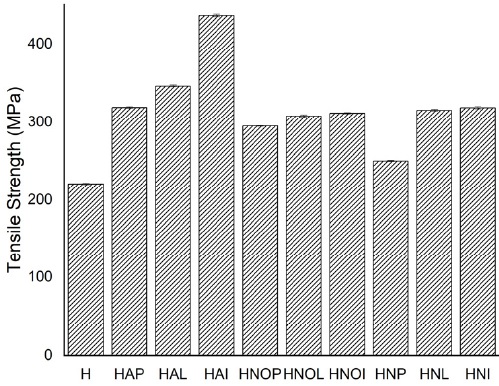
Figure 1. Evolution of tensile strength values of the experimental 5083 alloy samples, in different structural state.